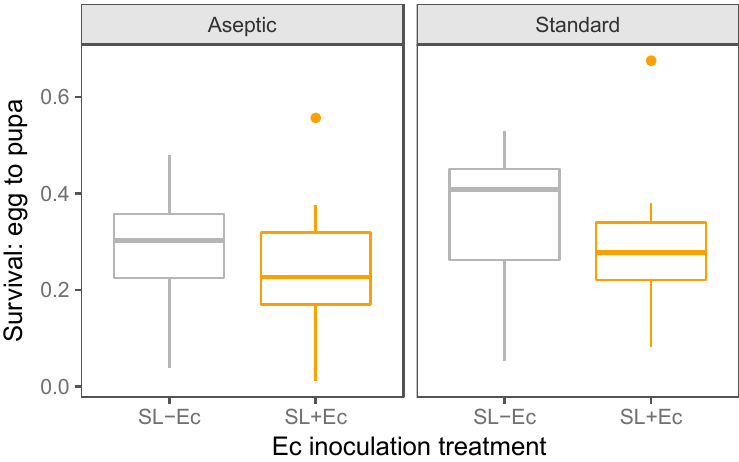
Figure 2. Survival egg to pupa for self-limiting insects in both aseptic and standard conditions, and with and without E. cloacae inoculation ( + Ec–Ec). Eggs were counted on parafilm strips before being added to rearing containers, and the numbers of healthy pupae recorded after seven days. In the aseptic experiment, survival was recorded in 25–26 Petri dishes in each inoculation treatment, while under standard condition survival was assessed in 11–12 tubs per treatment.